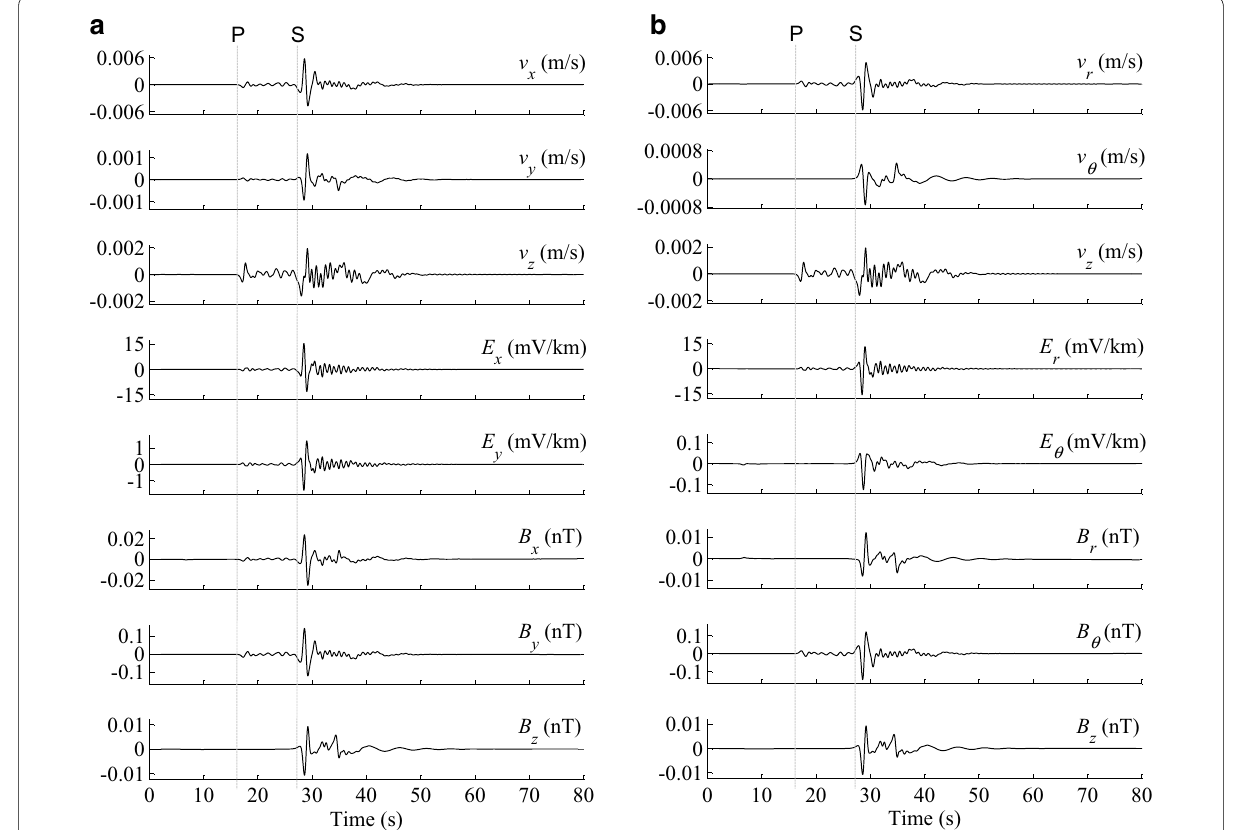
Fig. 8 Seismic and EM signals recomputed for the seven‑layer half‑space model. The receiver is still located at ( surface‑charge density of Q sc 0.02 C/m 2 is considered. The simulated seismic and EM wave‑fields are displayed in a Cartesian and b cylindrical = − coordinates,